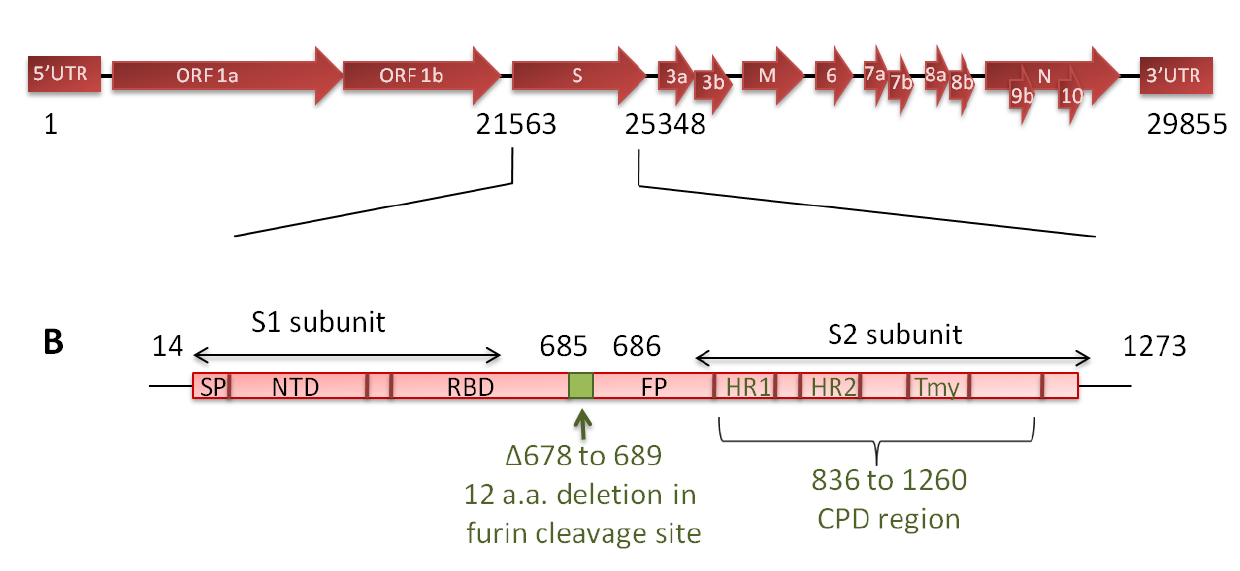
Figure 1. Schematic representation of the live attenuated SARS-CoV-2 vaccine strain (dCoV). ( A ) Genome consists of 29,855 nucleotides. Spike gene (21,563–25,348 nucleotides) contains 36 nucleotides deletion corresponding to 12 amino acids (Δ678 to 689) and 283 nucleotides mutation to achieve codon pair de-optimization. ( B ) Spike protein region and the relative positions of deletion of 12 amino acids at furin cleavage site and codon pair de-optimized region (CPD) after translation.